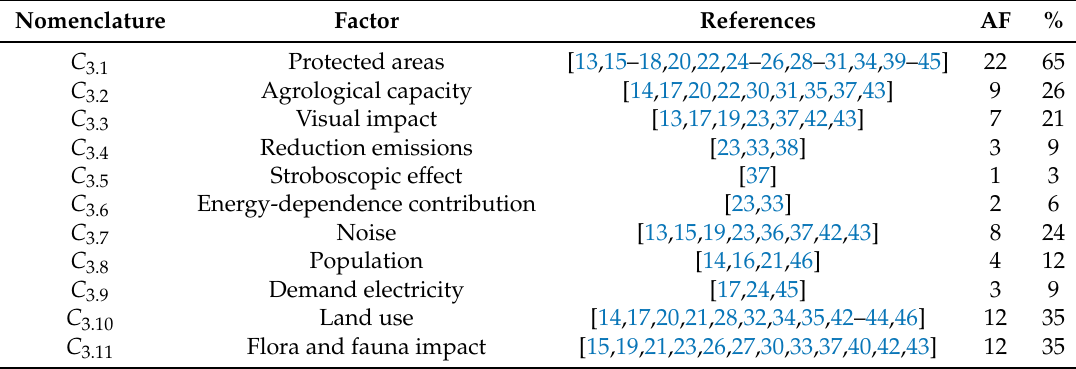
Table 9. Socio-environmental Category ( C 3 )—Onshore wind energy. Quantitative